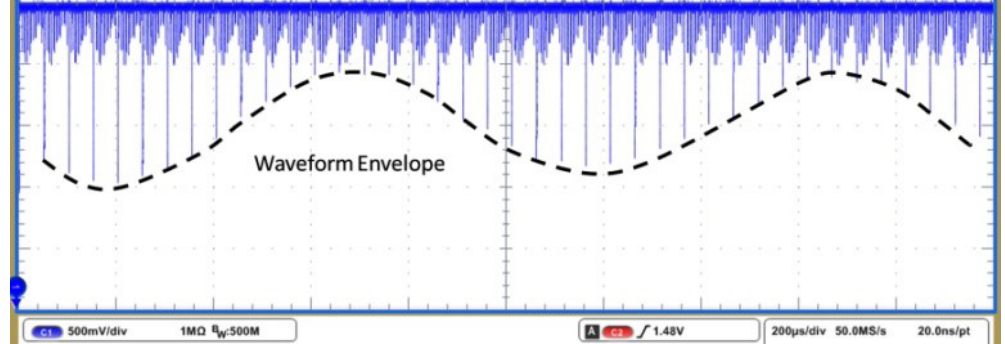
Figure 8. Measured output waveform from the recording chip in continuous mode with a sampling rate of 20 kHz. The envelope of a single channel that had a 1 kHz sinusoidal input is highlighted with the dashed